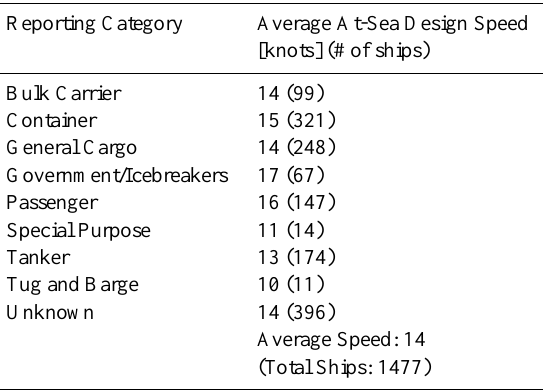
Table 2. Average Design Speed of Ships Operating in the Arctic (AMSA,